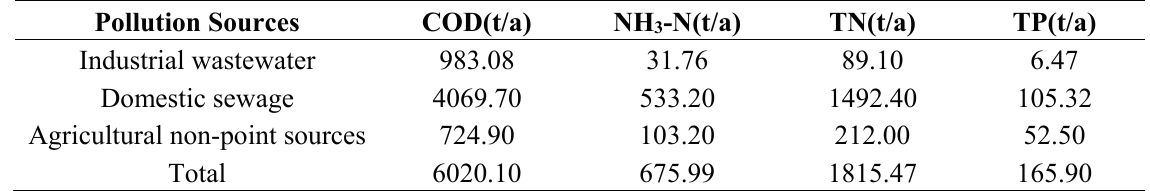
Table 7. Annual emissions of COD, NH3-N, TN, and TP in Wujin River